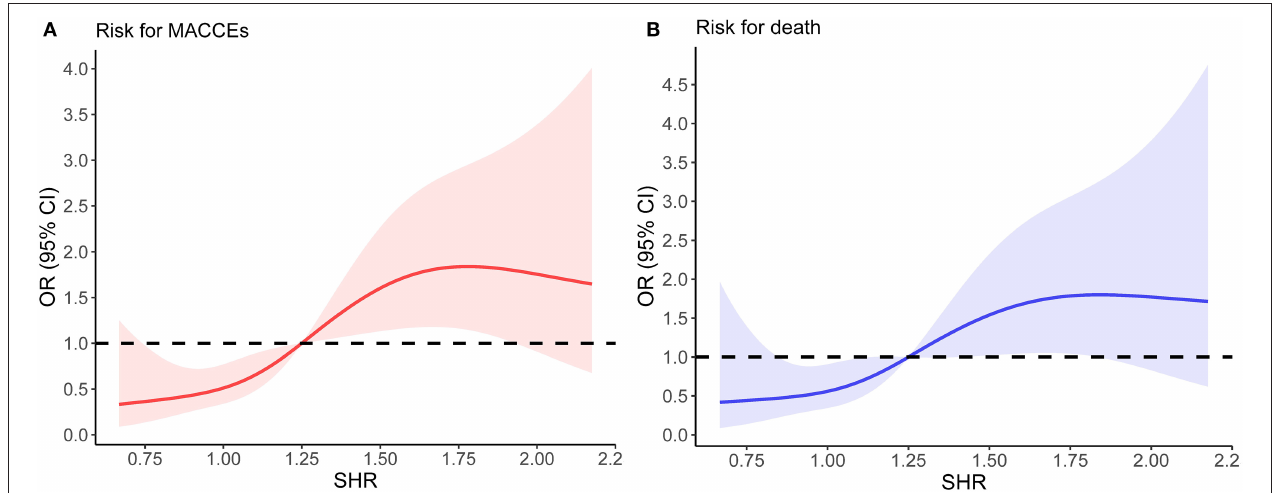
FIGURE 2 | The relationship between SHR and the risk of in-hospital outcomes. (A) Non-linear dose–response relationship between SHR and in-hospital MACCEs. (B) Non-linear dose–response relationship between SHR and in-hospital mortality. In (A,B) , the x-axis is SHR level. The y-axis is the odds ratio, with the shaded area representing a 95% confidence interval. The threshold value of SHR (1.25) was set to 1.0 (referensce). OR, odds ratio; CI, confidence interval.